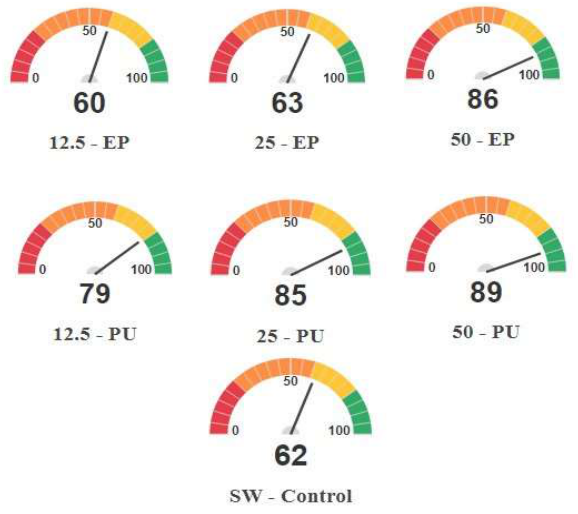
Figure 3. Germination indexes (GI) of cress seeds grown on compost extracts of inorganic BA comparing to the SW-control. Green range indicates full stability, and yellow range indicates the negative effect to root elongation.